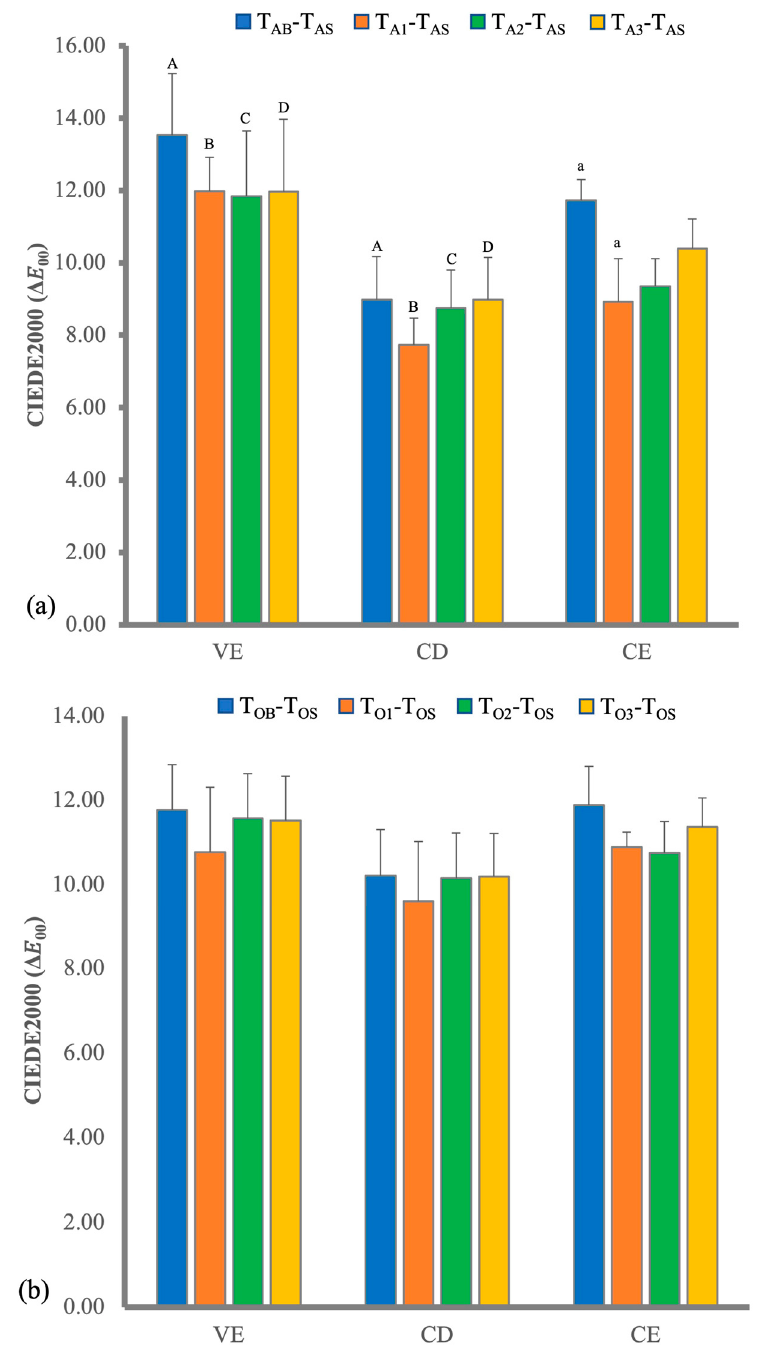
Figure 1. CIEDE2000 values ( ∆ E 00 ) of the three materials at different periods for ( a ) at-home bleaching, and ( b ) in-office bleaching. VE, Vita Enamic; CD, Celtra Duo; CE, Ceresmart. Subgroups identified by same superscript lowercase letters were significantly different within groups; subgroups identified by same superscript uppercase letters were also significantly different between groups ( p < 0.05).